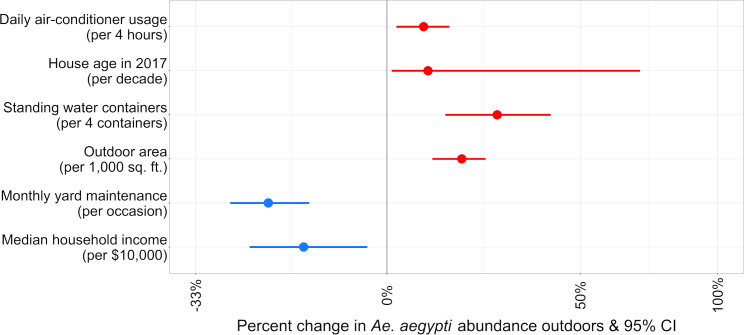
Rate ratios for census-tract and household-level predictors included in final multiple hierarchical Poisson regression model for Ae. aegypti detections outdoors. For clarity, rate ratios are expressed as a percentage change for each covariate. The model was adjusted for mosquito collector, average daily temperature of the seven days prior to collection, and collection date. Red indicates a risk factor (P < 0.05) and blue indicates a protective behavior (P < 0.05). X-axis is on the logarithmic scale.